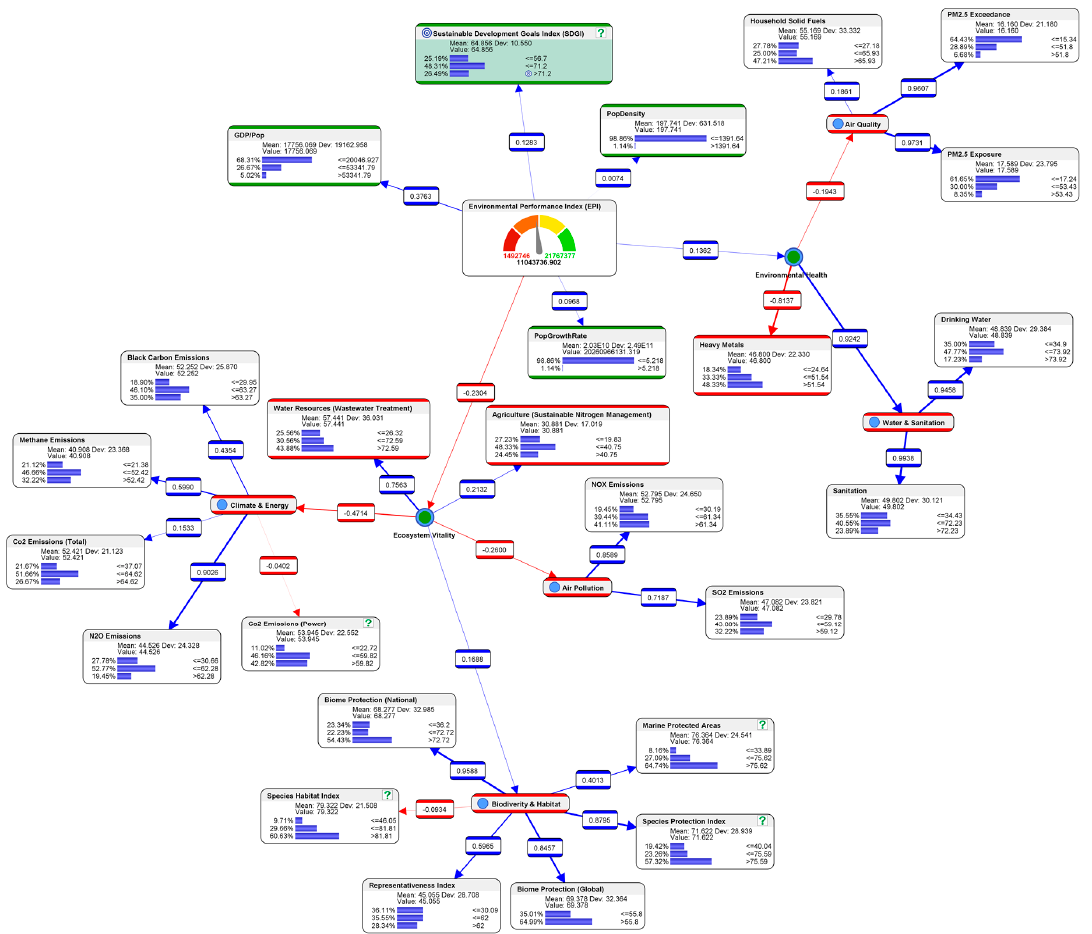
Figure 1. Descriptive modeling of current state of 2018 EPI data. Table 2. Results of descriptive analysis of the 2018 EPI data.